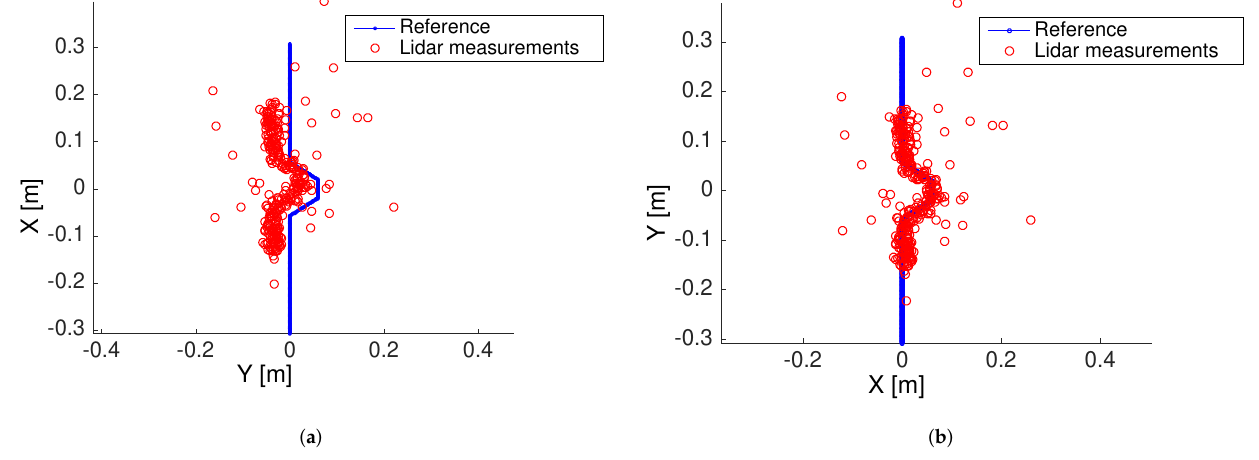
Figure 5. Scan-matching results using Hausdorff distance considering all measurements ( a ) and 80% of the best matching points ( b